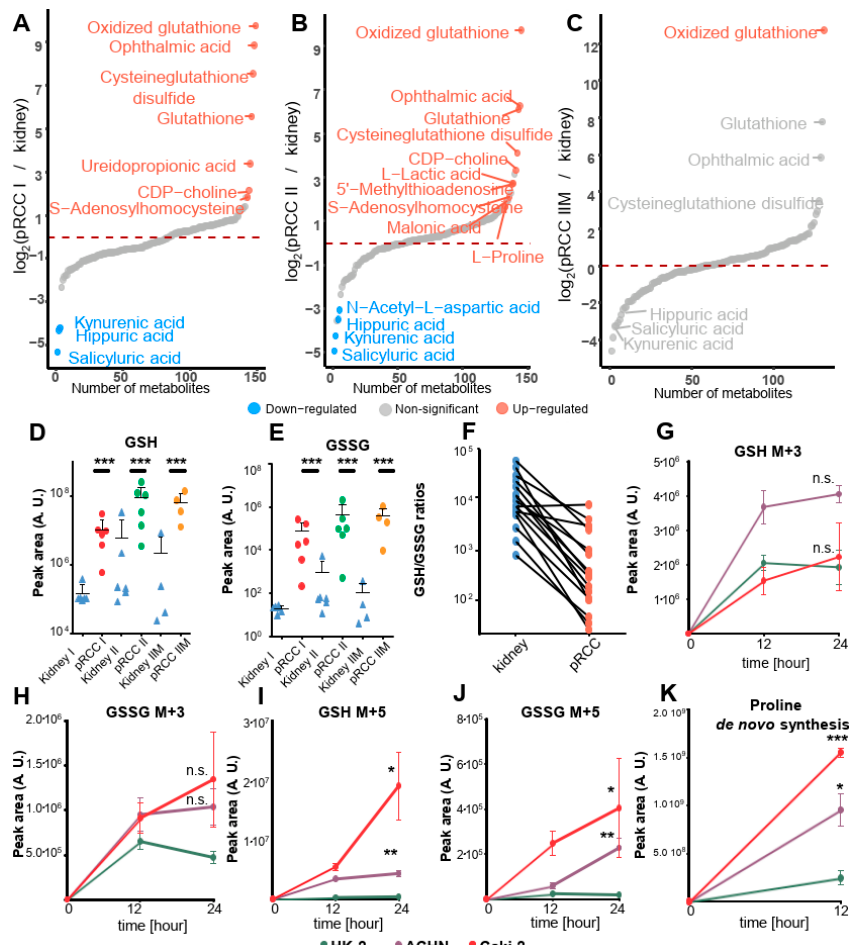
Figure 6. Metabolome profiling, specific abundancies of reduced and oxidized glutathione in tissues, and de novo synthesis of glutathione in papillary renal cell carcinoma (pRCC) Metabolome profile of ( A ) pRCC type I ( n = 6), ( B ) pRCC type II ( n = 6), and ( C ) pRCC type IIM ( n = 4) versus kidney tissues. Significantly (FDR < 0.05) up- and down-regulated metabolites are shown in red and blue, respectively. ( D ) Relative abundance of glutathione (GSH) and ( E ) of oxidized glutathione (GSSG) in the tissues and ( F ) the according case-specific GSH/GSSG ratios. Metabolic tracing of ( G , H ) 13 C 6 glucose and of ( I , J ) 13 C 515 N glutamic acid to monitor GSH ( G , I ) de novo synthesis and its